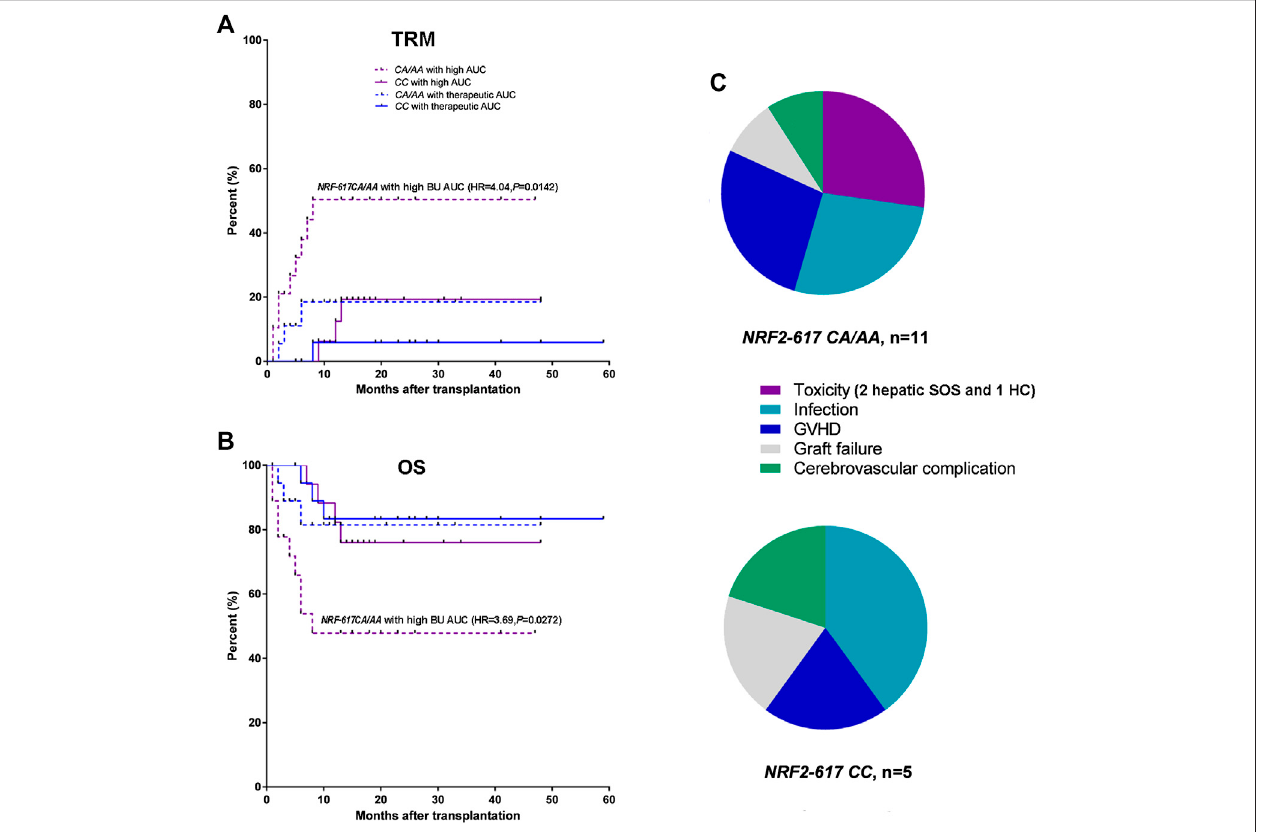
FIGURE3| NRF2-617CA/AA genotypespredictedhighTRMandpoorOSinadultpatientswithabovetherapeuticAUC( n (cid:1) 75). (A) Kaplan-MeyercurvesofTRM and (B) OS according to BU AUC and NRF2 -617C/A genotypes. Blue and red lines represent the mortality or survival curves for the patients with therapeutic AUC ( n (cid:1) 40)andwithhighAUC( n (cid:1) 35).Solidanddottedlinesrepresentthecurvesforthepatientswithwildtype( CC )andwithheterozygousorhomozygousgenotype( CA / AA ) . ( AA / CA inthepatientswiththerapeuticAUC, n (cid:1) 19; CC inthepatientswiththerapeuticAUC, n (cid:1) 21; AA/CA inthepatientswithhighAUC, n (cid:1) 19; CC inthepatients withhigh AUC, n (cid:1) 16) (C) Pie-chart representation ofTRM causes of death in the patientswith NRF2 -617CA/AA ( n (cid:1) 11) and NRF2 -617CC ( n (cid:1) 5). The toxicities were hepatic SOS (2 patients) and hemorrhagic cystitis (1 patients).